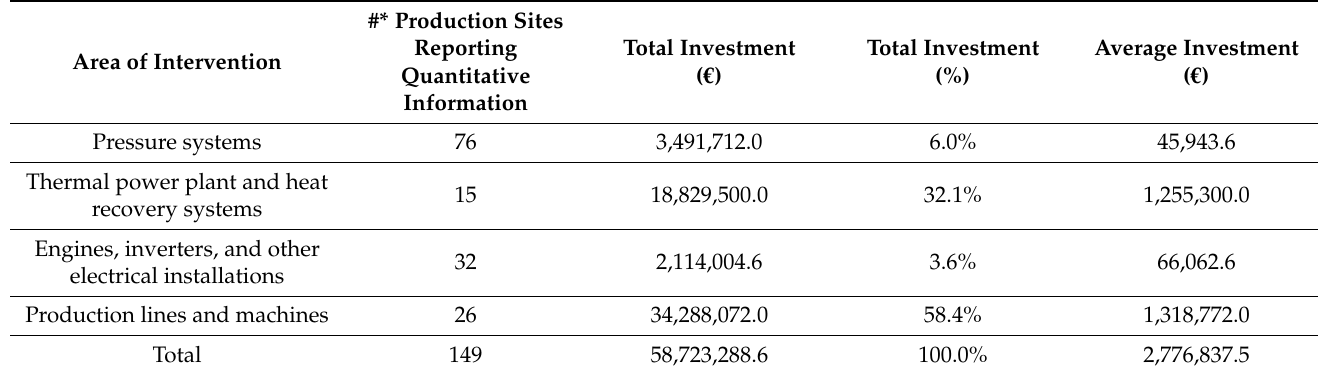
Table 8. Investments assessed for the suggested interventions.